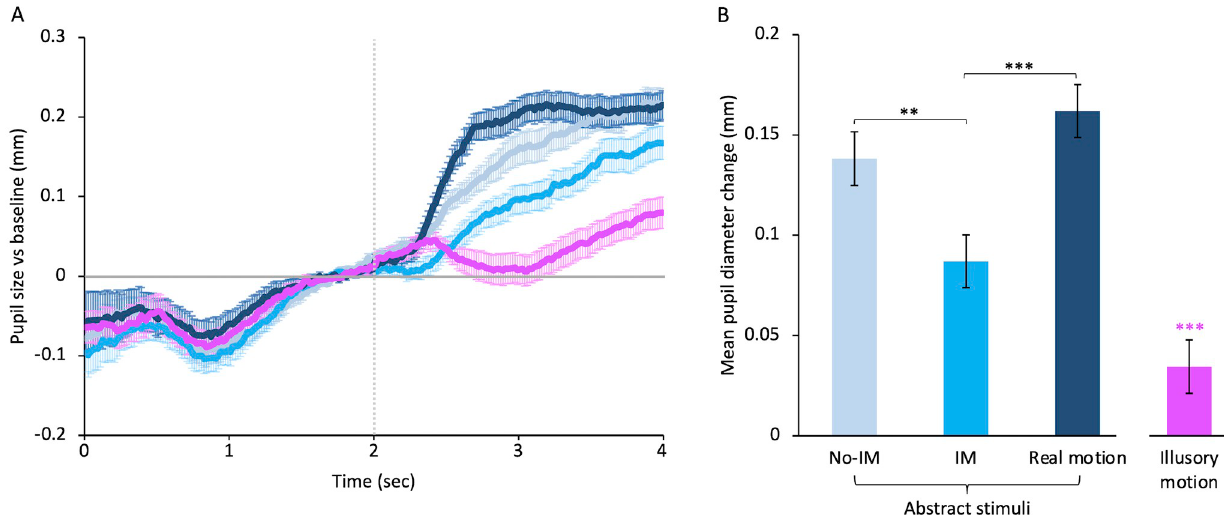
Fig 3. Pupillary responses to motion in abstract stimuli and to illusory motion. (A) Baseline-corrected pupil size for the different abstract stimuli and motion illusions plotted as a function of time from trial onset. The horizontal line represents the baseline: Data over the zero-line represent pupil dilation whereas data under the line represent pupil constriction. The vertical line indicates the stimulus onset. Error bars are SE. (B) Mean pupillary diameter for different abstract categories and motion illusions during stimulus presentation. Error bars are SE. Color saturation of bars for abstract stimuli increases with motion strength, in order: Paintings with no implied motion (No-IM), paintings depicting simple implied motion (IM); movies of moving objects (Real motion). Purple bar: Illusory motion. Examples of paintings of each abstract category are shown in Fig 1C. Black asterisks mark statistically significant pairwise comparisons across abstract motion categories; pink asterisks denote significant differences with illusory motion: ��� p < 0.001, �� p < 0.01. All data shown have been corrected based on each observer’s motion rating test.